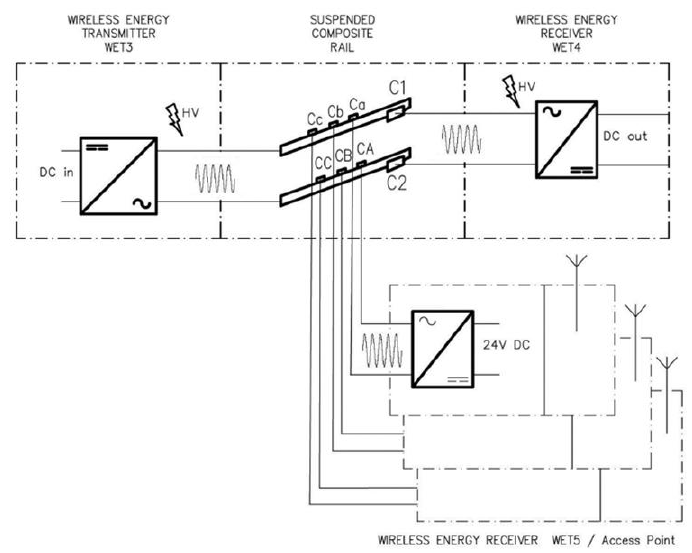
Figure 4. Concept of energy transfer in a WET system with additional low-power energy receivers to supply access points via capacitive coupling.